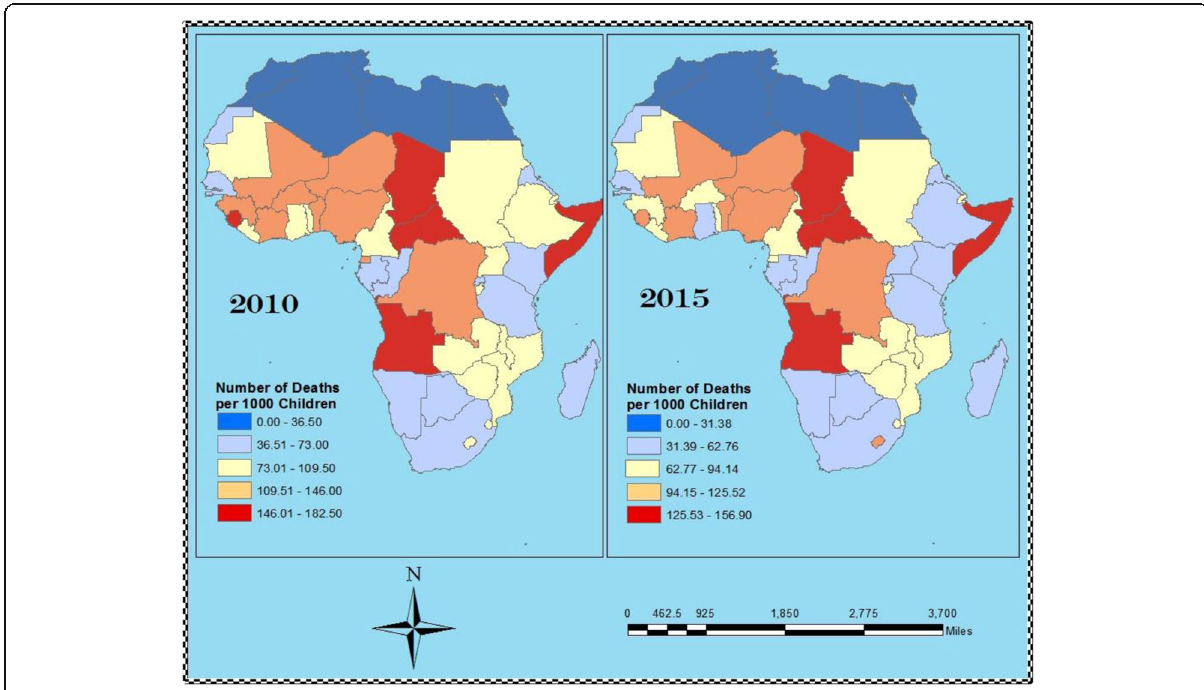
Fig. 1 Equal Interval Distribution of Under-five Mortality Rate in Africa for 2010 (left) and 2015 (right) (data obtained from UN IGME, 2016)